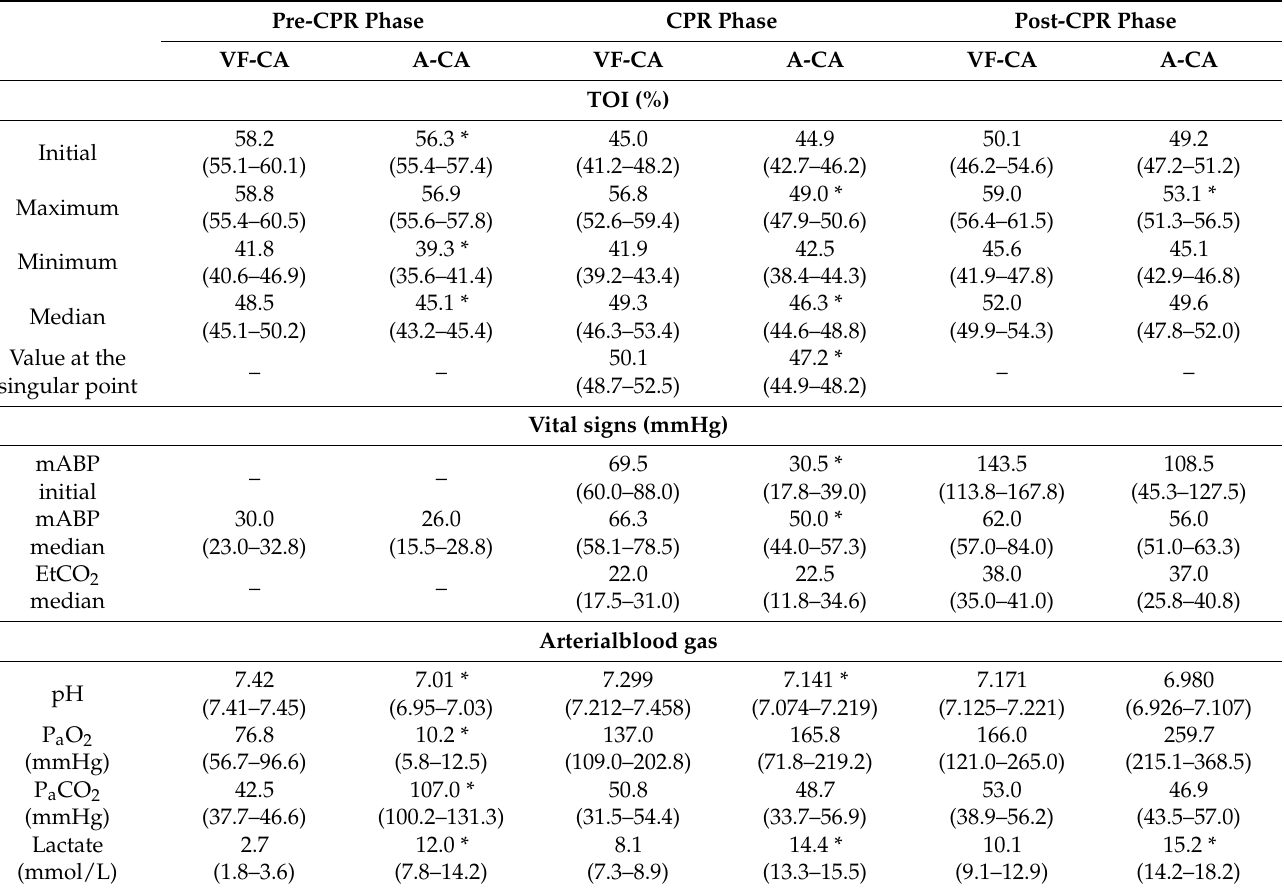
Table 2. Comparison of the ventricular fibrillation cardiac arrest (VF-CA) and asphyxial cardiac